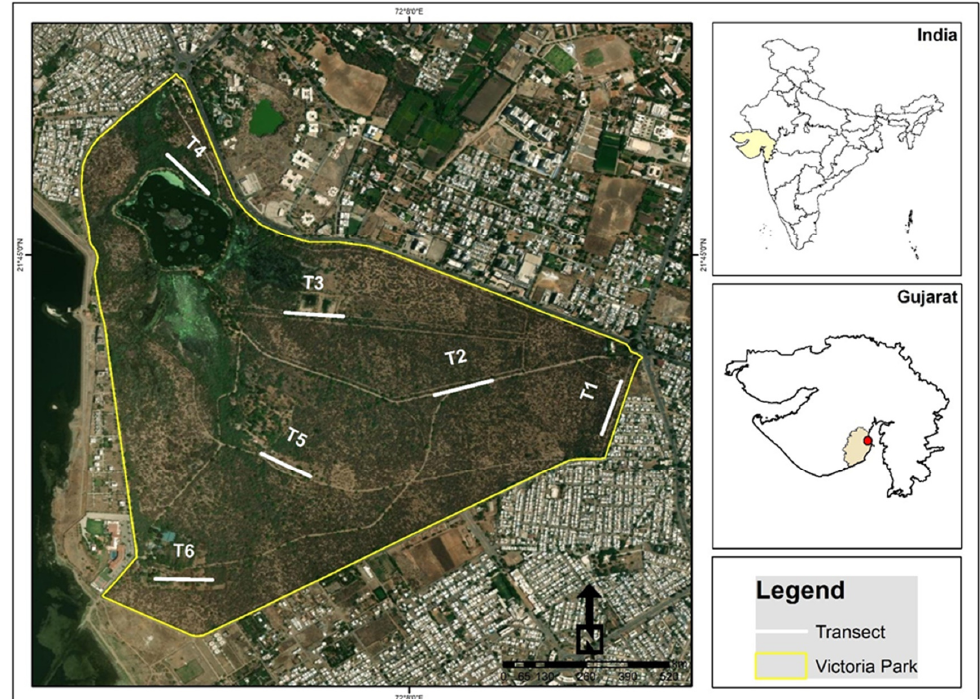
Figure 1. Map of the study